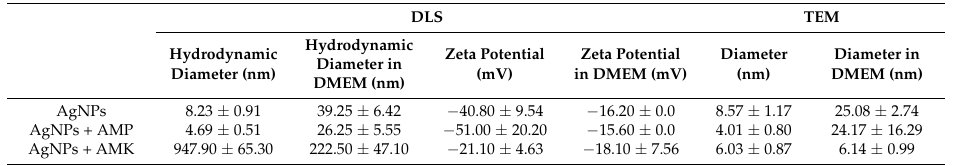
Table 1. Characterization of silver nanoparticles and their combinations with antibiotics by DLS and TEM.